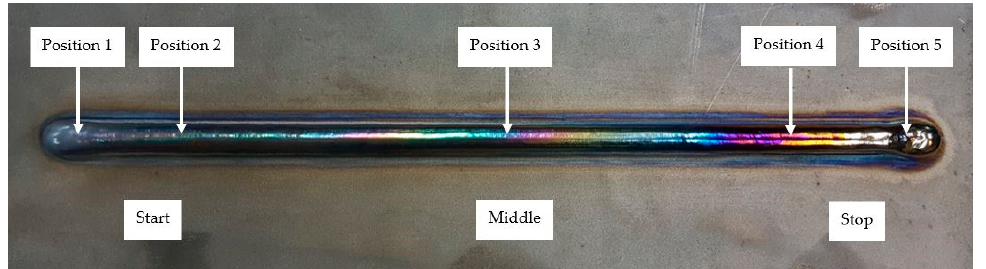
Figure 4. Positions of the weld bead height and bead width measurement for the hot-wire plasma welding process. Table 4. The parameters used for the hot-wire plasma welding process.